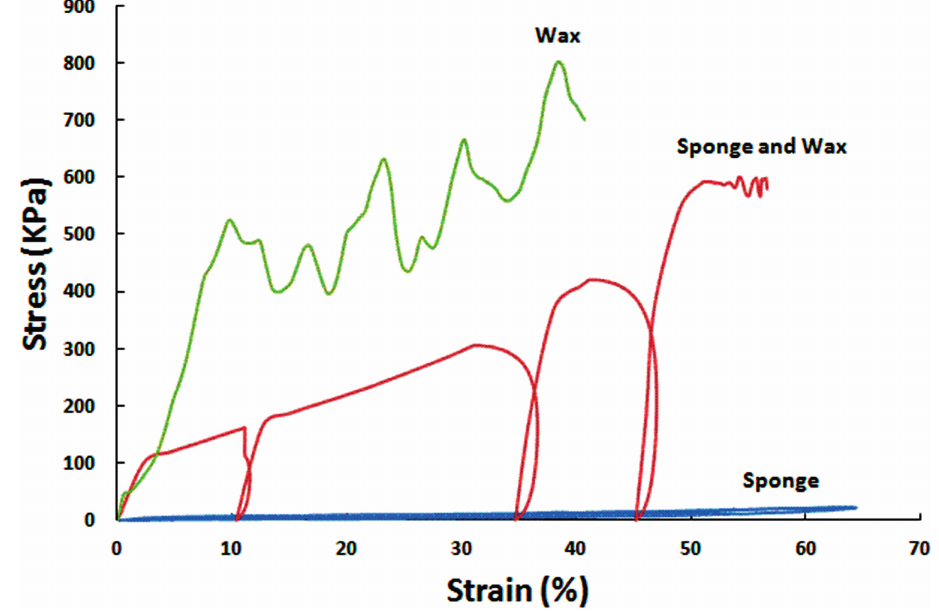
Figure 6. Engineering stress vs. engineering strain relationships of sponge, sponge-wax hybrid and wax in uniaxial